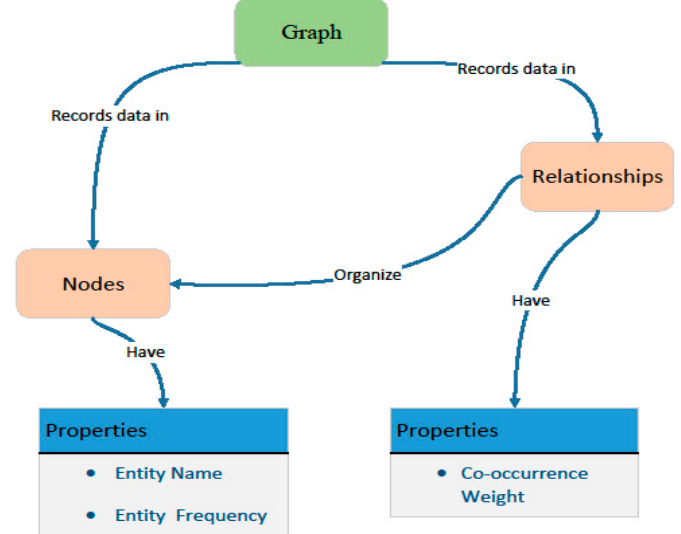
Figure 2. The graph structure for visual representation.